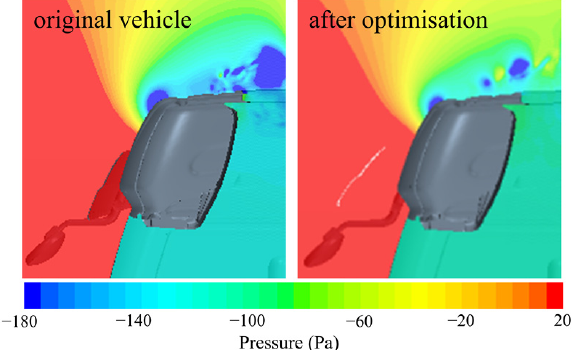
Figure 12. The pressure contour curve of the cab forehead before and after optimization.